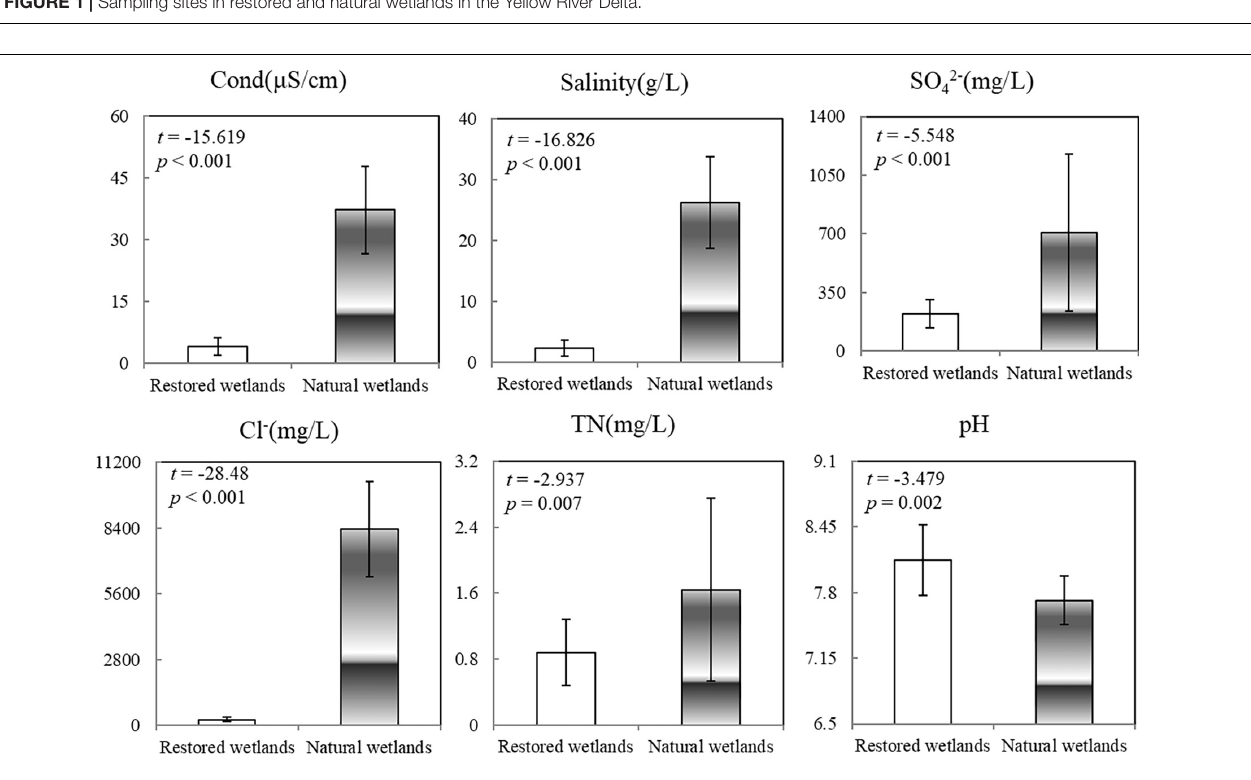
FIGURE 1 | Sampling sites in restored and natural wetlands in the Yellow River Delta.